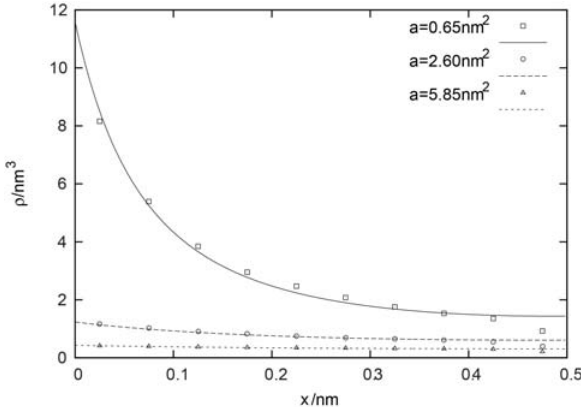
Figure 6. Density profiles of positive part of zwitterions at Debye length equal to 1 nm. Corresponding monovalent salt concentration is 0.092 mol/L. Symbols represent Monte Carlo data and lines the- ory. Legend: (cid:3) and full line: a = 0.65 nm 2 ( σ = –0.2465 C/m 2 ); (cid:2) and - - -: a = 2.60 nm 2 ( σ = –0.0616 C/m 2 ); (cid:2) and - - -: a = 5.85 nm 2 ( σ = –0.0274 C/m 2